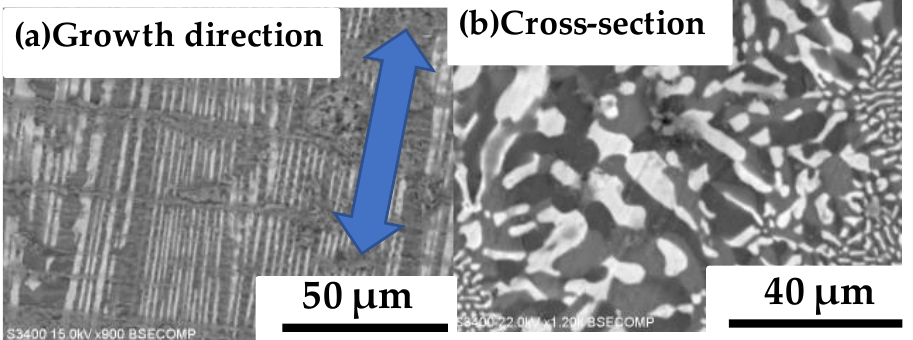
Figure 4. The BEI of the wafers of ( a ) vertical and ( b ) transverse cross-section. The blue arrow indicates the pulling direction.